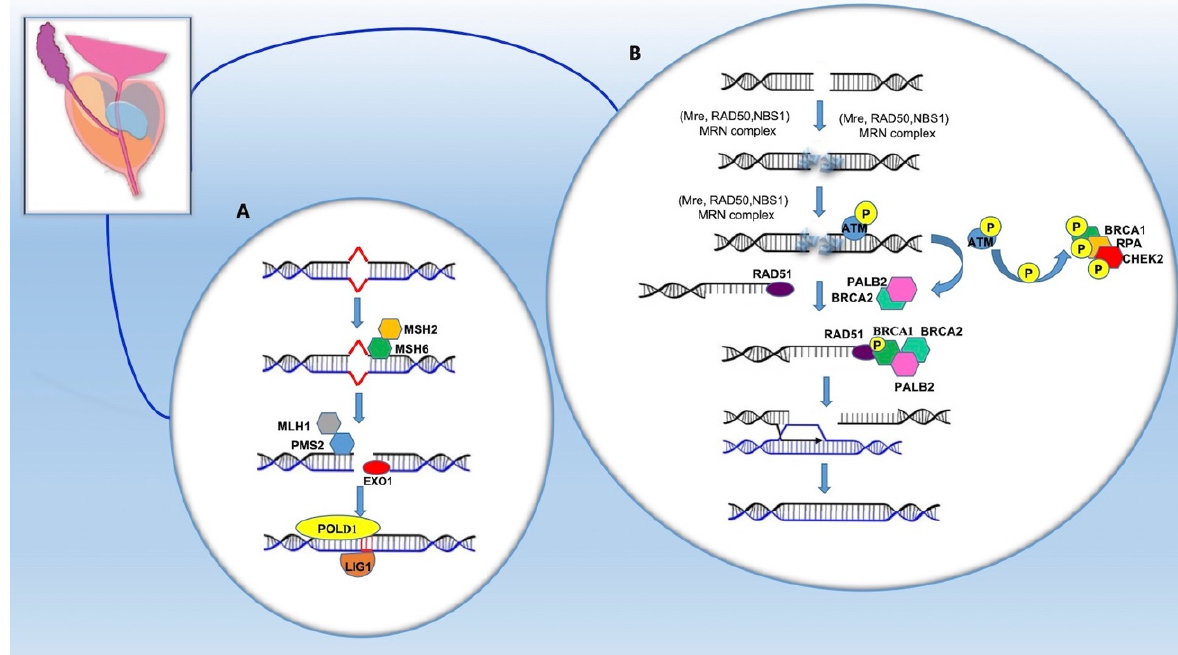
Figure 2. DNA repair pathway in the prostate epithelium involving hereditary prostate cancer (HPCa) related genes: mismatch repair or MMR ( A ); homologous recombination or HR ( B ). See text for detailed description. mutS homolog 2 (MSH2); mutS homolog 6 (MSH6); mutL homolog 1 (MLH1); PMS1 homolog 2 (PMS2); Exonuclease 1 (EXO1); δ polymerase (POLD1); DNA ligase I (LIG1); Meiotic recombination 11 (MRE11); Double strand break repair protein (RAD50); Nijmegen disruption syndrome proteins (NBS1); Replication protein A (RPA); ATM serine/threonine kinase (ATM); Breast cancer type1 (BRCA1); Checkpoint kinase 2 (CHEK2); RAD51 recombinase (RAD51); Breast cancer type2 (BRCA2); Partner and localizer of BRCA2 (PALB2).